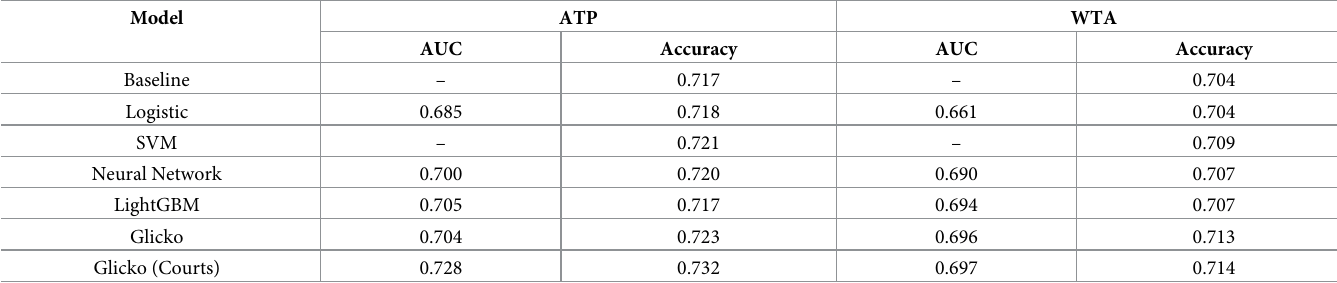
Table 4. Model accuracy of single matches (non-moving